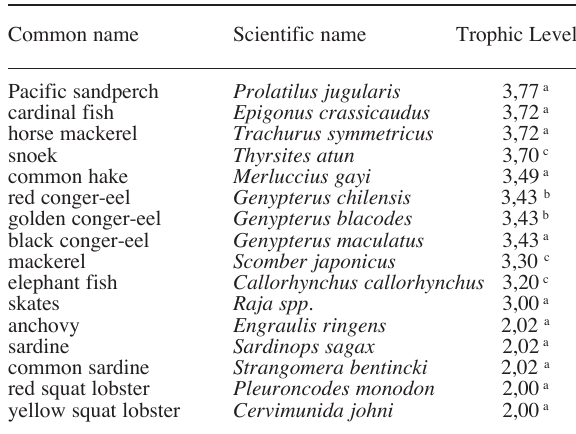
Table 1. – List of the species included in this study and their corre- sponding trophic level. (a): estimated in this study using gut content analysis (Lillo et al ., 1993; Arancibia, 1992; Arrizaga, 1983; Arrizaga et al ., 1993; Cordova et al ., 1999) and the Ecopath with Ecosim software; (b): assigned assuming these species have a diet composition similar to G. maculatus , which was estimated in this study; (c): FishBase (Froese and Pauly,